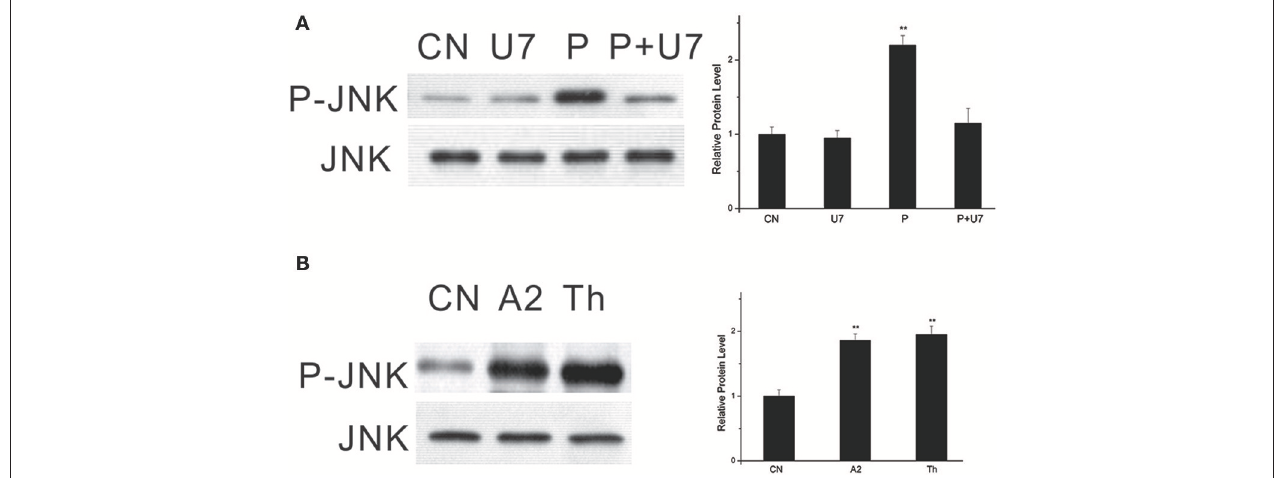
FIGURE 3 | Effect of U73122 on PTTH-stimulated JNK phosphorylation (A) and stimulation of JNK phosphorylation by A23187 and thapsigargin (B) . (A) Effect of U73122. PGs were pretreated with either 10 µ M U73122, or the vehicle alone for 30min and transferred to medium containing the same dose of U73122, with or without the PTTH. CN, glands incubated in control medium; P, glands incubated in medium containing the PTTH only; U7: glands incubated in medium containing U73122 only; P + U7, glands incubated in medium containing both the PTTH and U73122. (B) Effects of A23187 and thapsigargin. Gland lysates were prepared and subjected to an immunoblot analysis with anti-phospho-JNK (P-JNK) and anti-JNK (JNK) antibodies. Results shown in the left panels are representative of three independent experiments. Data are expressed as multiples of change over the respective control after being normalized to the JNK level. Asterisks indicate a significant difference compared to the respective control (by Student’s t -test, ** p < 0.01).